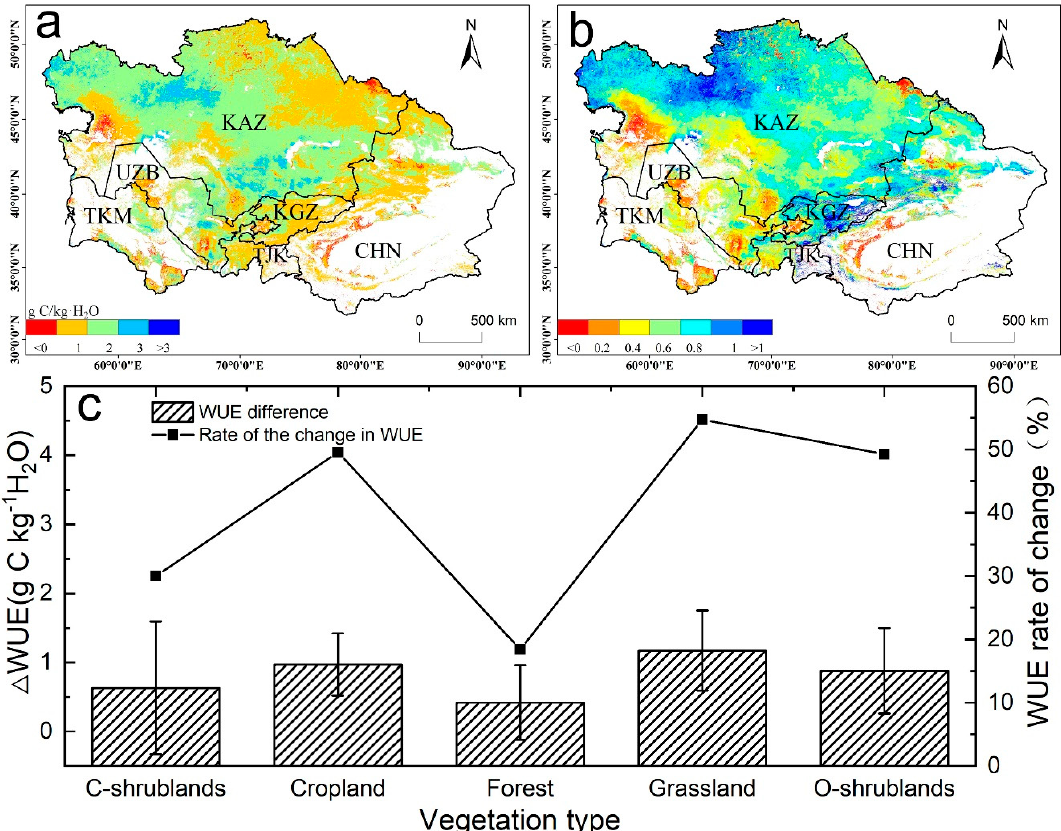
Figure 9. ( a ) Overall changes, ( b ) the rate of change, and ( c ) WUE changes in the different biomes under the transition from dry years (2000–2010) to wet years (2011–2014).